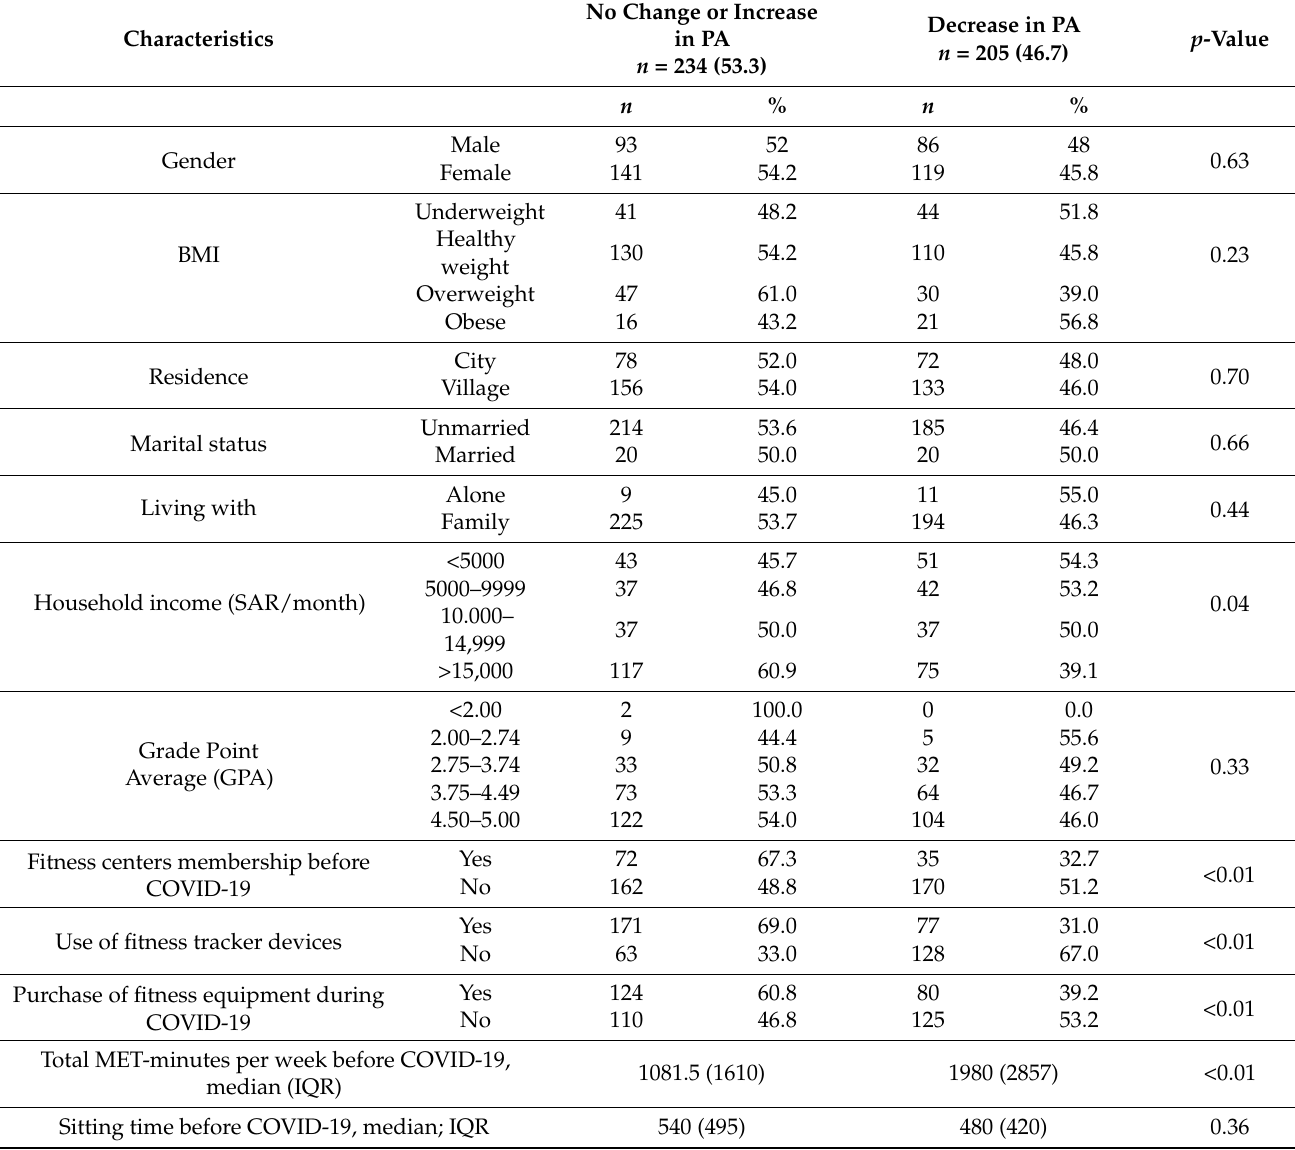
Table 2. The sociodemographic structures of the study participants according to the change in PA level during the COVID-19